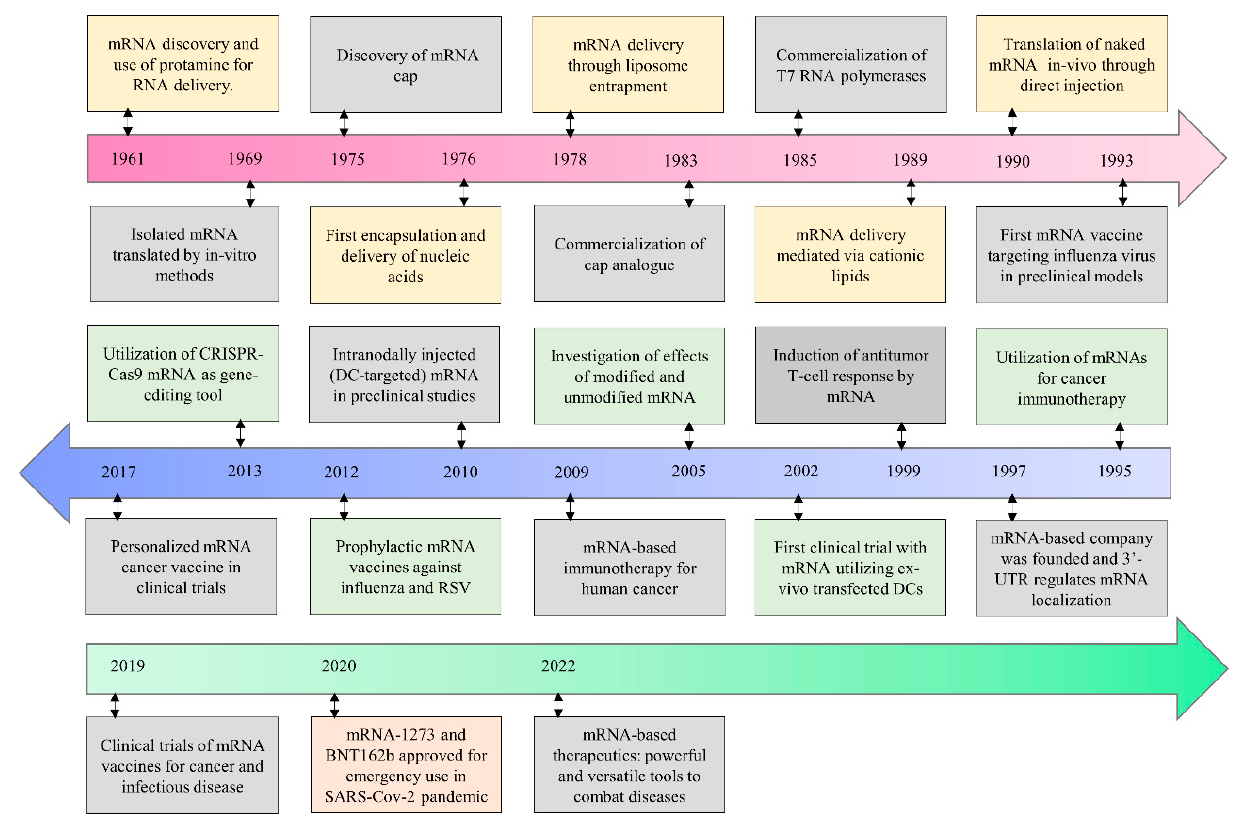
Figure 1. Historical developmental milestones for mRNA-based therapeutics. (Modified under Creative Commons Attribution 4.0 International License from [7]).